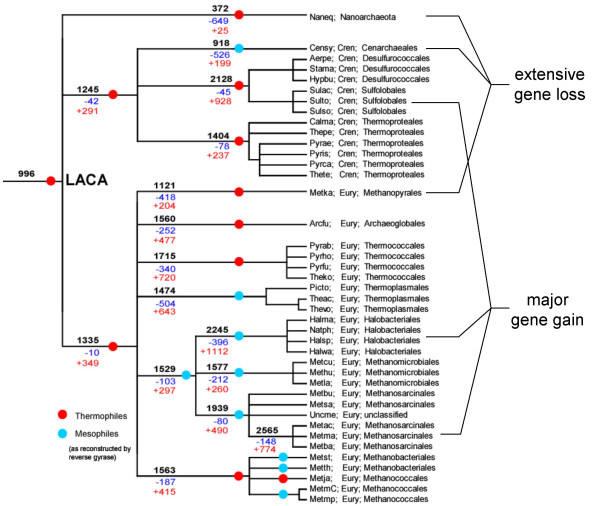
A reconstruction of gene gain and loss in archaea. Each branch is labeled by 3 numbers: black, the (inferred) number of arCOGs in the node to which the given branch leads; blue, number of arCOGs lost along the branch; red, number of arCOGs gained along the branch. The red circles on branches denote hyperthermophiles, and blue circles denote mesophiles and moderate thermophiles.